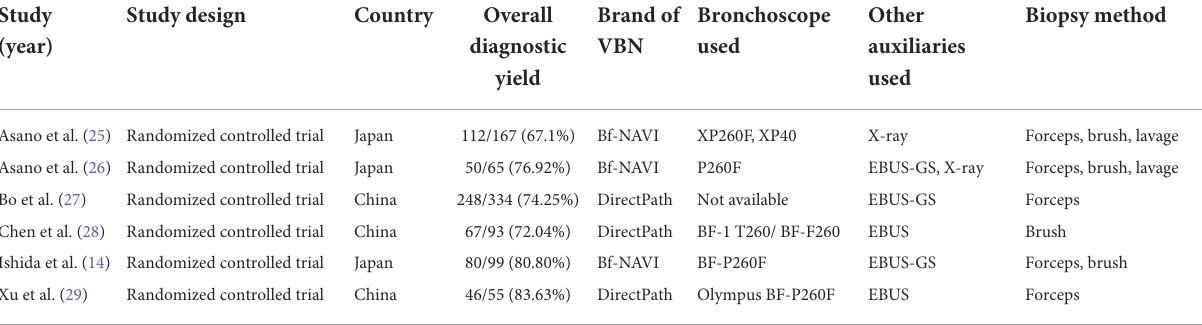
TABLE 1 Randomized controlled trials on VBN for the diagnosis of peripheral pulmonary